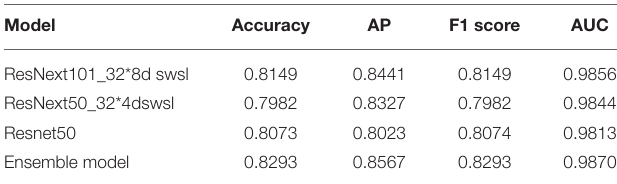
TABLE 2 | The performance of the deep learning model for the classification of types of WBCs.